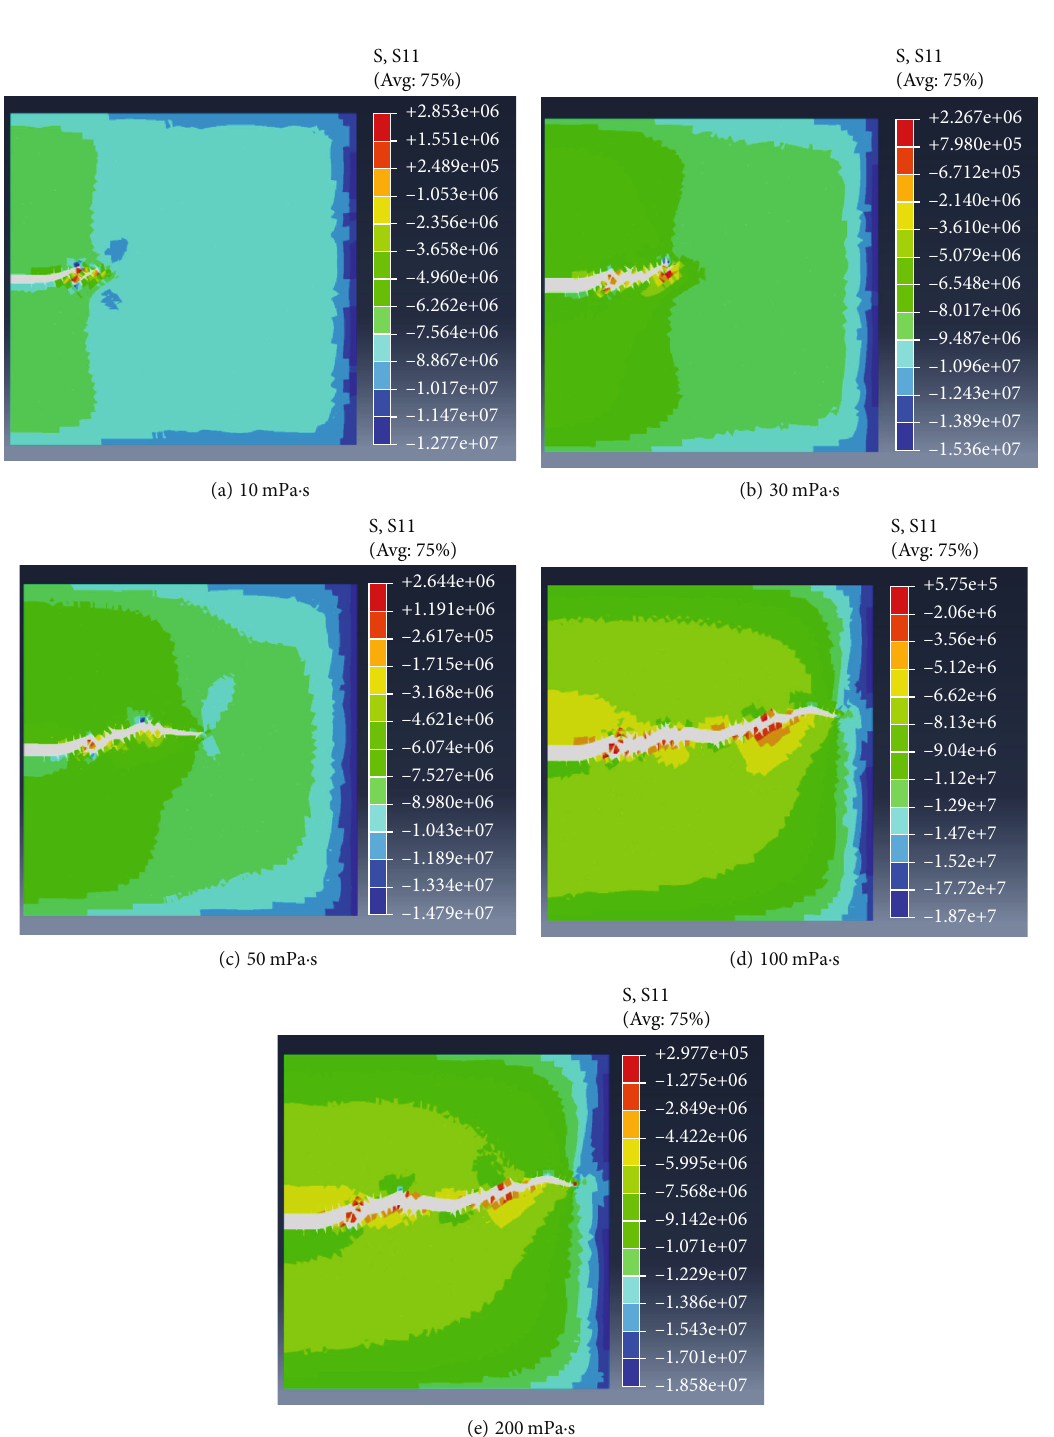
Figure 30: Stress contour map at the NF approaching angle of 45 ° and under fl uid viscosity of 10-200 mPa ·